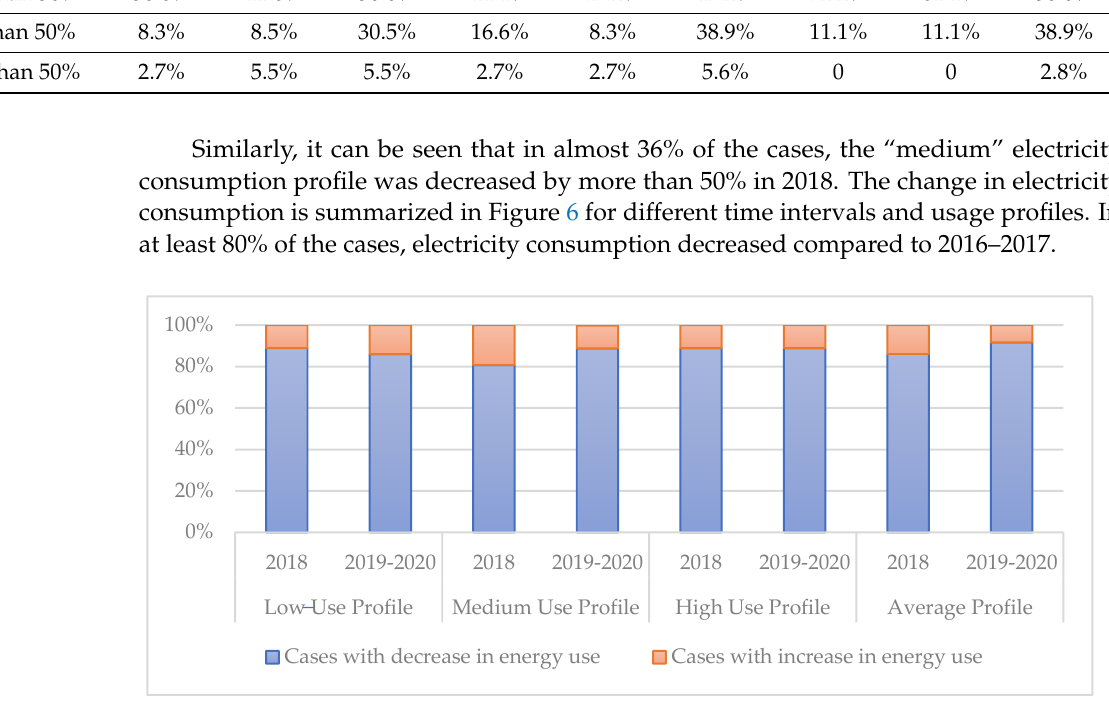
Figure 6. Impacts of changes in electricity rates on different consumption profiles.